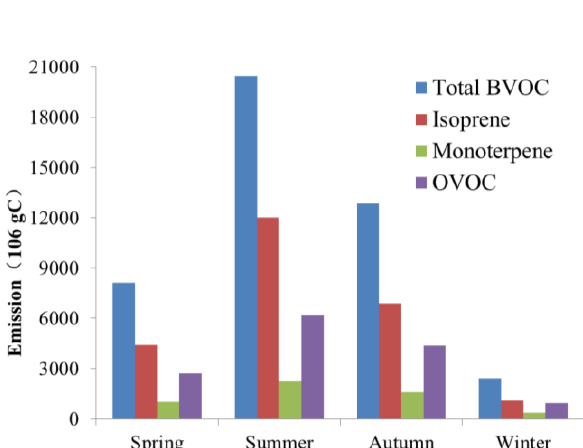
Table 4. Percentage of BVOC emission in each district,